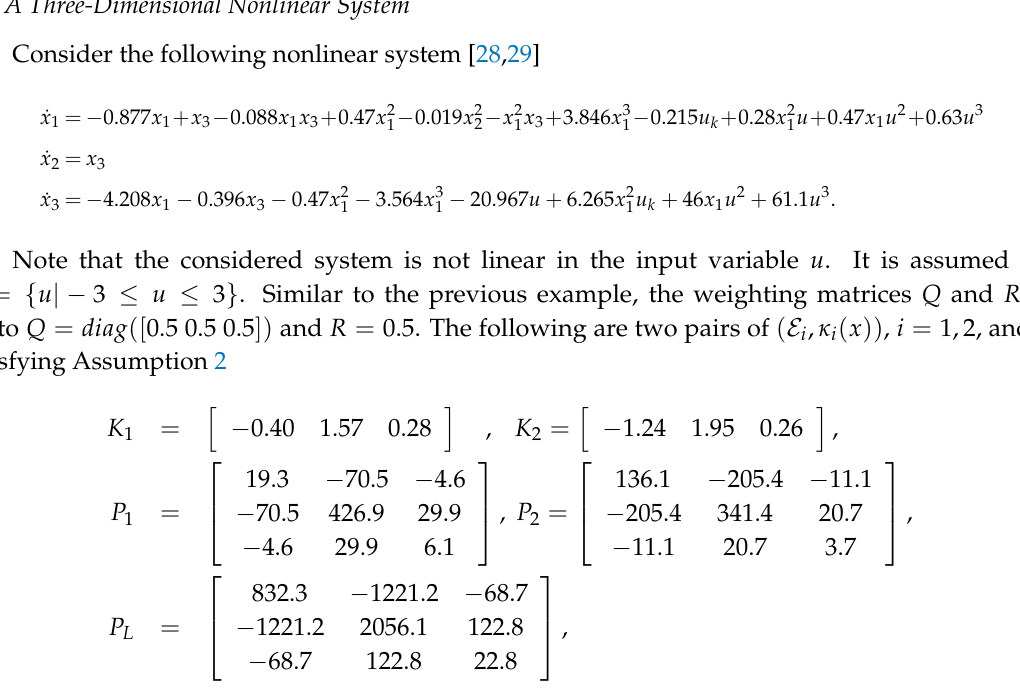
x T Qx t + u T Ru t is computed using 22 initial states which are t = 0 t t